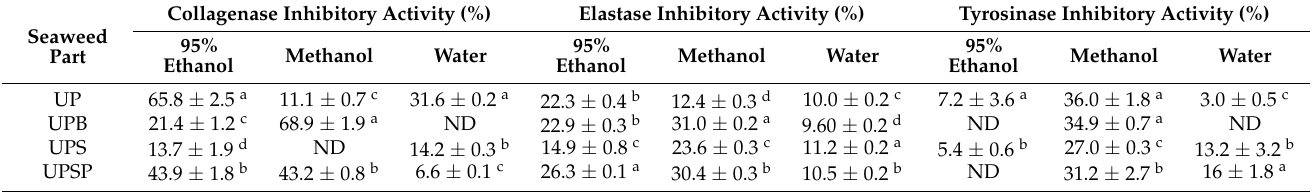
Table 4. Collagenase, elastase, and tyrosinase inhibitory activities of different parts of Undaria pinnatifida . Collagenase Inhibitory Activity (%) Elastase Inhibitory Activity Seaweed Part